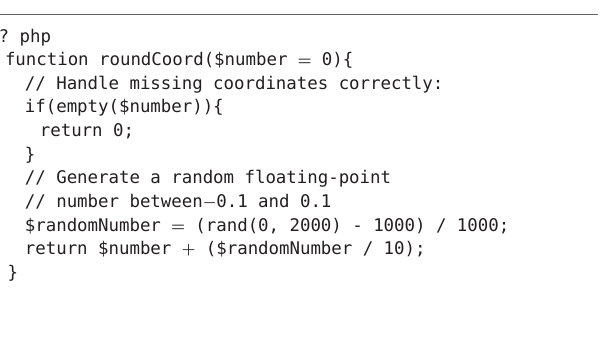
TABLE 4 | Obfuscation